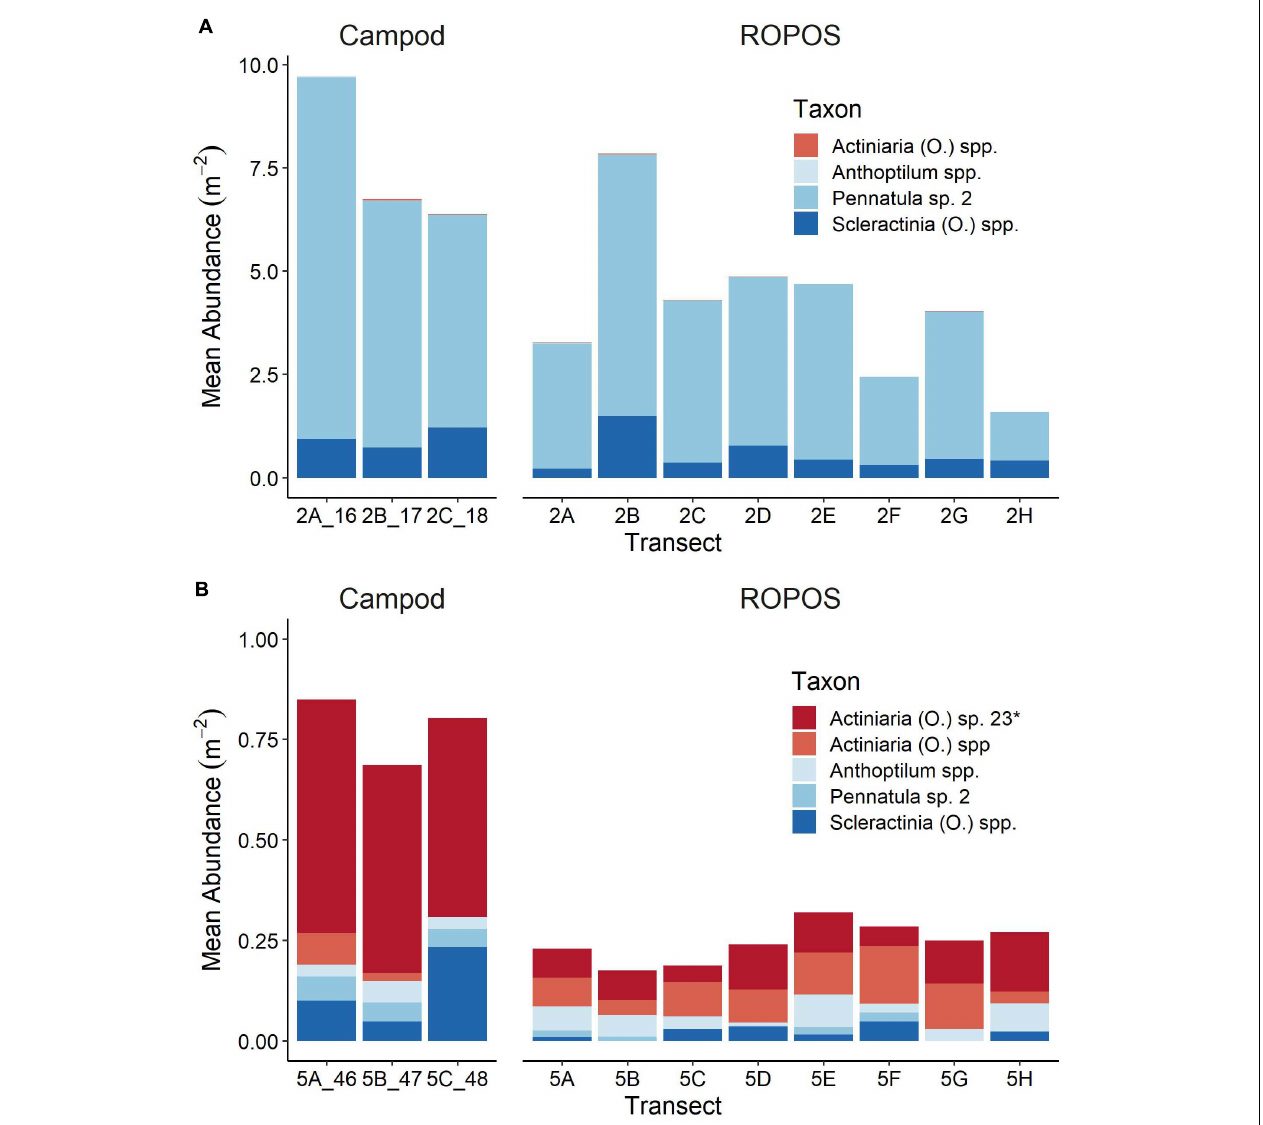
FIGURE 5 | Mean abundance of individuals or colonies m − 2 in each transect for abundant taxa (present in at least 11 of 22 transects) at (A) station LC2 and (B) station LC5 in the Laurentian Channel MPA. Abundance was averaged across images for each transect ( n = 16–36), see Table 1 for number of images per transect. Different scales on y-axis, *denotes taxon that was only found at one of these